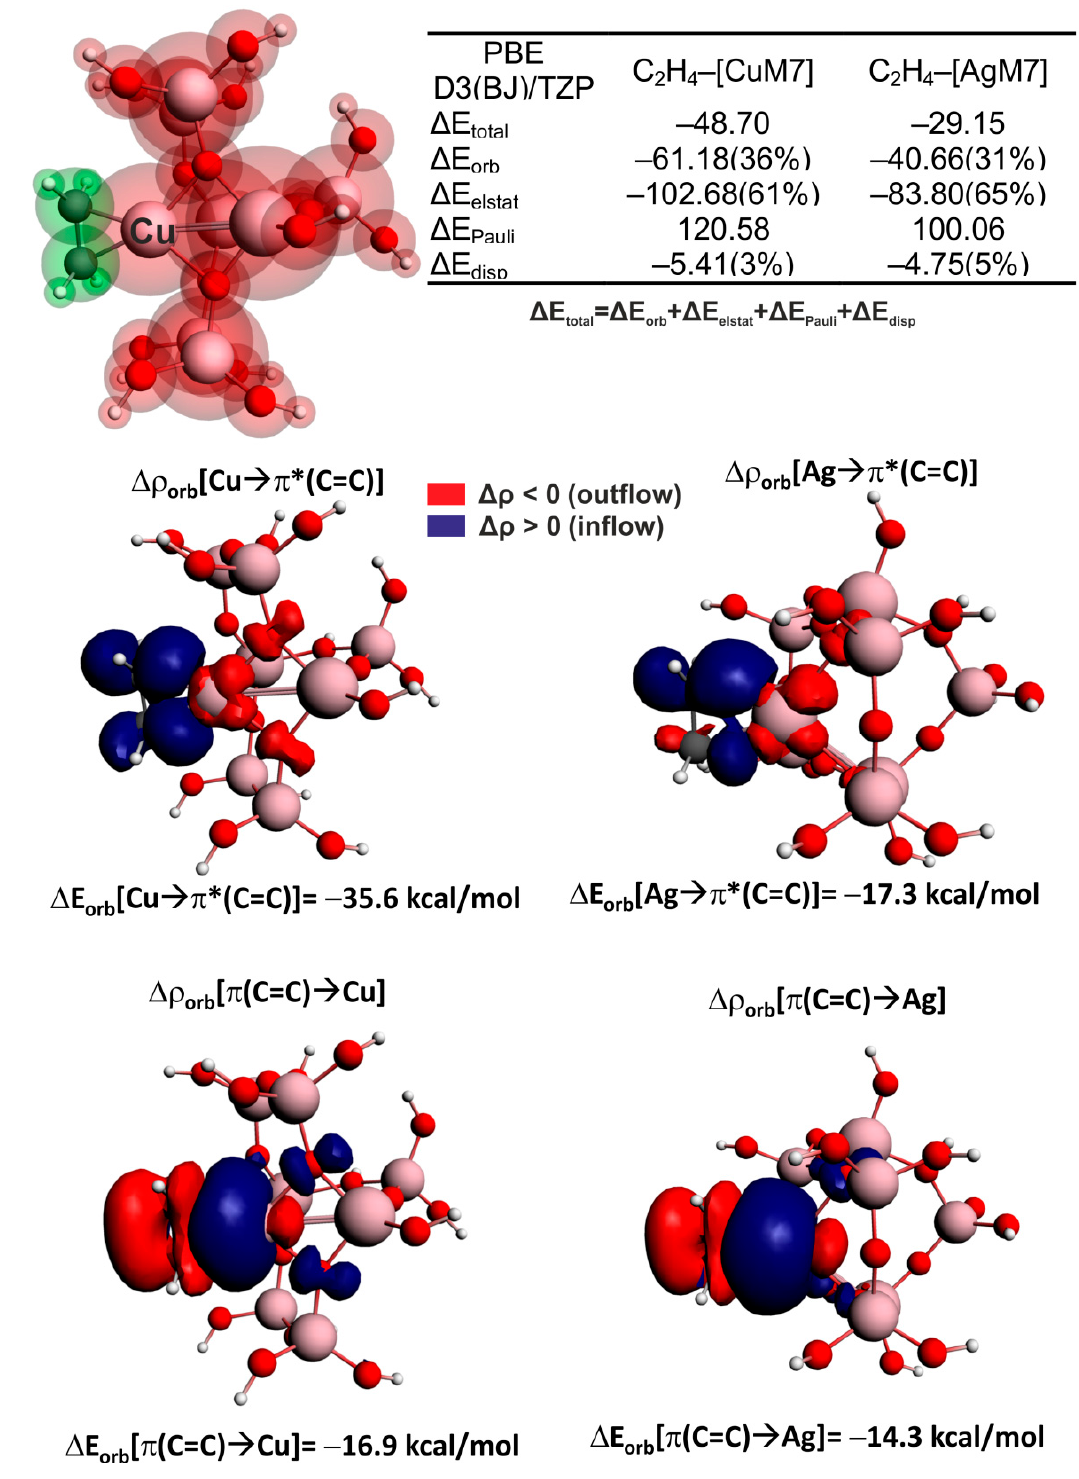
Figure 6. The results of ETS-NOCV/PBE-D3/ZORA/TZP energy decomposition describing [C 2 H 4 ]– [Cu/AgM7] bonding. Additionally, the most relevant NOCV-based deformation density channels Δρ orb (i), together with the corresponding energies, Δ E orb (i) are presented.